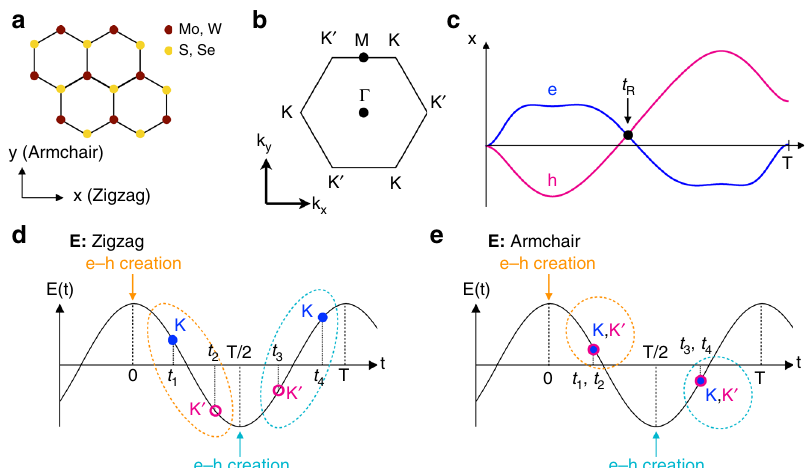
Fig. 3 electron – hole dynamics of HHG in monolayer TMDs. a Top view of the crystal of monolayer TMDs. The brown dots are transition-metal atoms, while the yellow dots are chalcogenide atoms. The x ( y ) axis corresponds to the zigzag (armchair) direction. b Two-dimensional hexagonal Brillouin zone of monolayer TMDs. The high symmetry, Γ , K ( K ’ ), M points are labeled. The electric fi eld with a polarization in the x ( y ) direction in real space drives carriers in the k x ( k y ) direction. c Schematic diagrams of the real space trajectories of electrons (blue curve) and holes (magenta curve) driven by light fi eld. The electron – hole pairs generated by Zener tunneling at t = 0 are accelerated by the electric fi eld, and they recombine when they meet again t ¼ t R ð Þ . d Schematic drawings of electron – hole creation and recombination dynamics under excitation with a polarization along the zigzag direction. The electron – hole pairs generated at t = 0 follow different traces depending on whether they were created at the K or K ’ point. Thus, the electron – hole pairs recombine at different times t 1 and t 2 (blue solid and magenta open circles in the dashed orange oval). The electron – hole pairs generated at t = T /2 follow reversed dynamics to those created at t = 0 (magenta open and blue solid circles in the dashed turquoise oval). e On the other hand, under excitation with the polarization along the armchair direction, the acceleration and recombination dynamics of the electron – hole pairs do not depend on whether the pairs were created at the K point or at the K ’